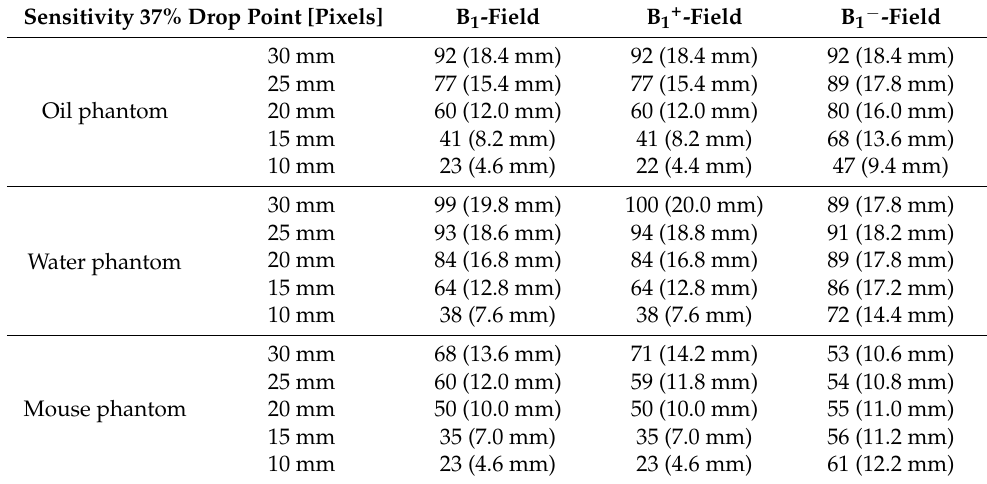
Table 3. The point where the sensitivity drops to 37% according to the change in size of single-channel surface RF coils using oil phantom, water phantom, and mouse